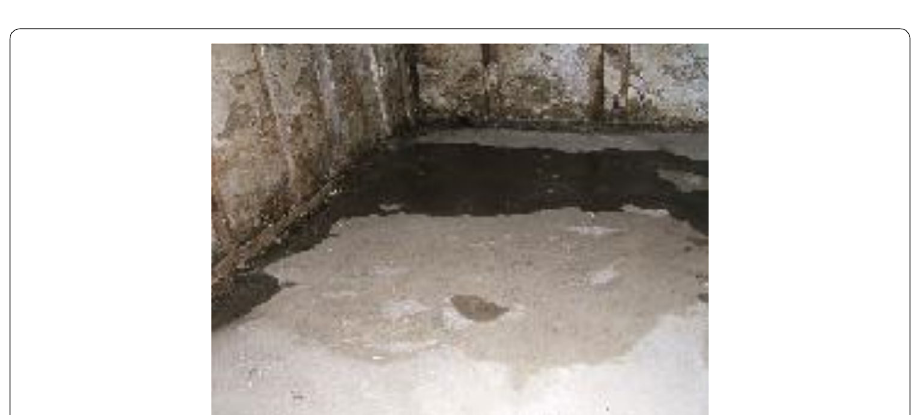
Fig. 3 Picture of seepage through building floor